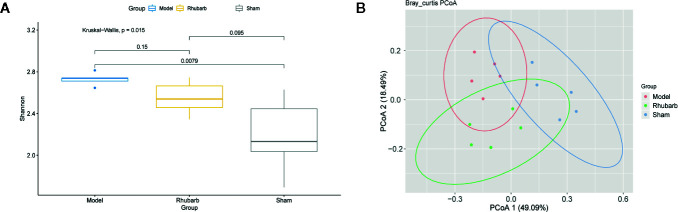
Rhubarb enema treatment modify the diversity of gut microbiota. The diversity of gut microbiota was significantly different among three groups. (A) The Shannon index of the model group was higher than the rhubarb enema group, and significantly higher than the sham group. (B) The principal component analysis (PCoA) plots were based on Bray-Curtis distance of the genus levels for 16S rDNA gene sequencing. Individuals (represented by points) were clustered into 3 groups. Permutational multivariate analysis of variance (PERMANOVA) was performed on dissimilarity matrices to assess the effects of groups with 10,000 permutations.